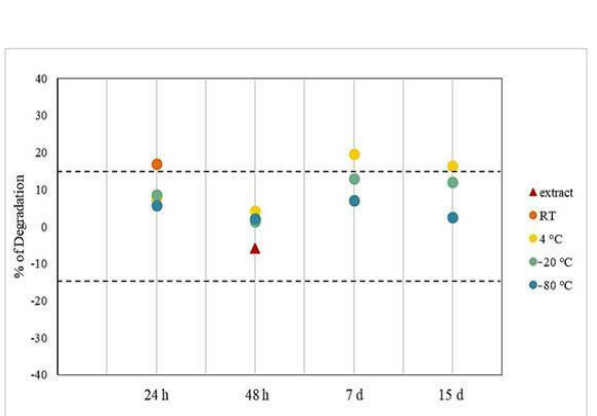
Figure 4. Stability of CNB in extracts and plasma samples at different storage conditions over two weeks, reported as the percentage of molecule degradation. For clarity only the average value re- ported in Table 3 is here represented. Dashed lines show acceptability range of ±15%.